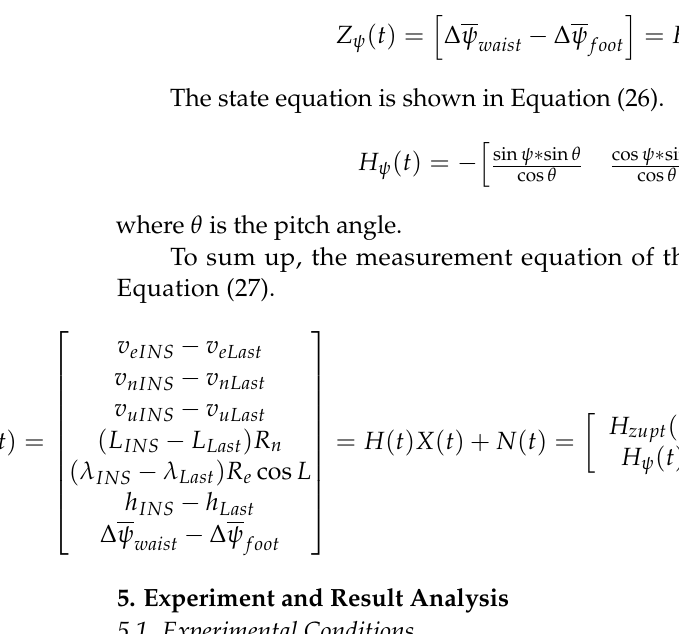
Figure 8. Comparison figures of heading of waist between heading of foot: ( a ) heading of waist; ( b ) enlarged view of heading of waist; ( c ) heading of foot; and ( d ) enlarged view of heading of foot. The measurement equation is shown in Equation